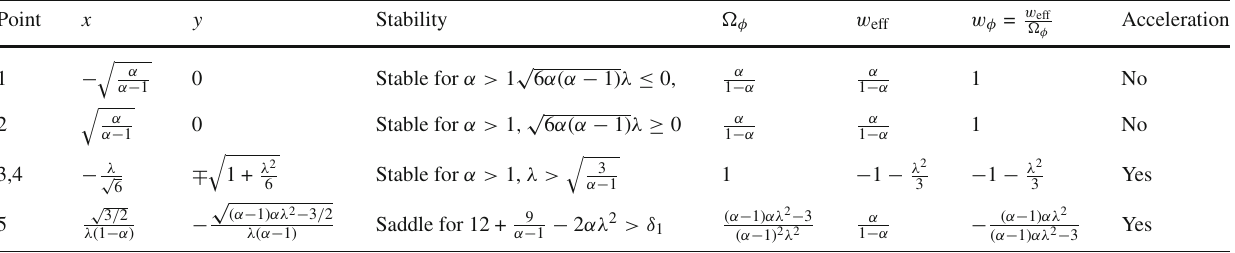
Fig. 2 This figure represents the phase portrait, evolution of w φ and dashed, dot-dashed and dotted lines correspond to α = − 1 , − 2 , − 3 (cid:3) φ of point (5) for Q = α ˙ ρ and − 5, respectively. The values of λ below the horizontal line are not m . This is an unstable point and acts as a sad- dle point that is shown in the left panel for α = − 0 . 3 and λ = 1 . 9. The allowed middle and right panels are plotted for different values of α . The solid, Table 1 We display stationary points for the coupling Q = α ˙ ρ m . We also show the expressions of (cid:3) φ ,w eff ,w φ and the conditions to have